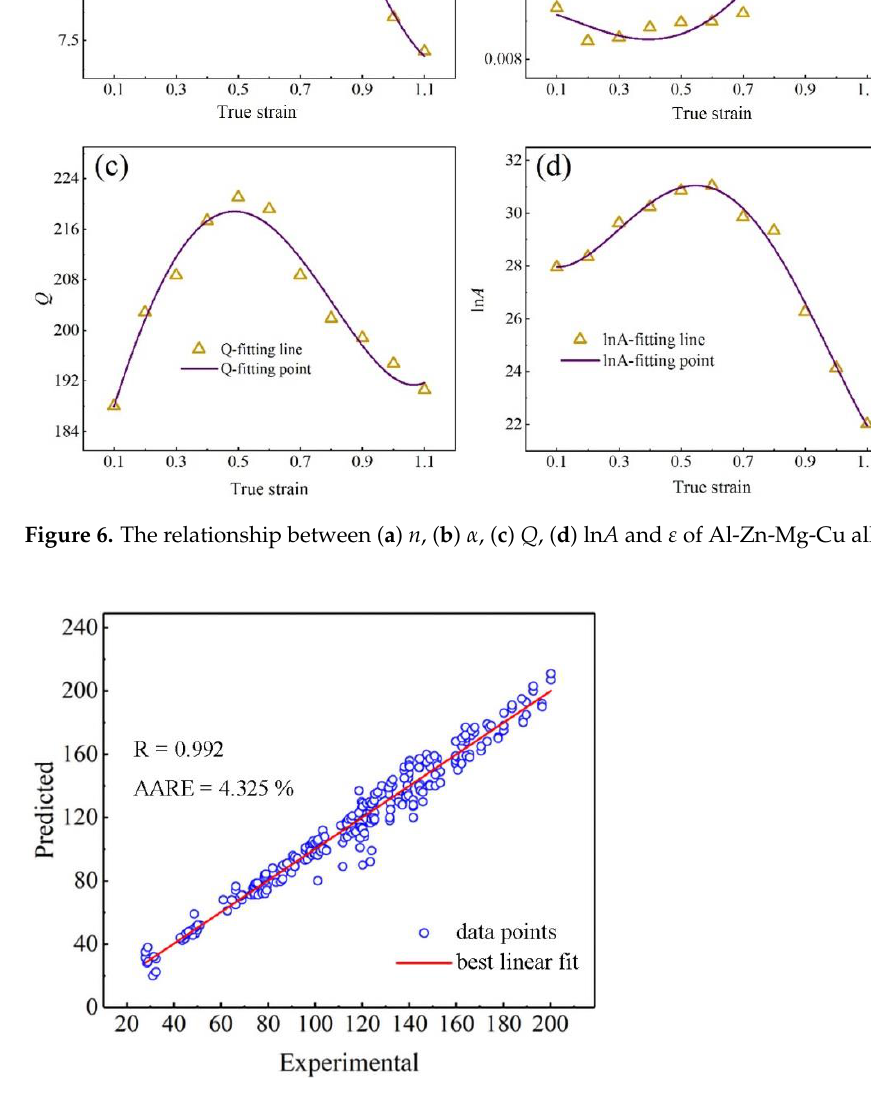
Figure 7. Experimental values and calculated values of the modified equation of Al-Zn-Mg-Cu alloy. R and R indicate a relative error and average relative error, respectively. Ac- er av